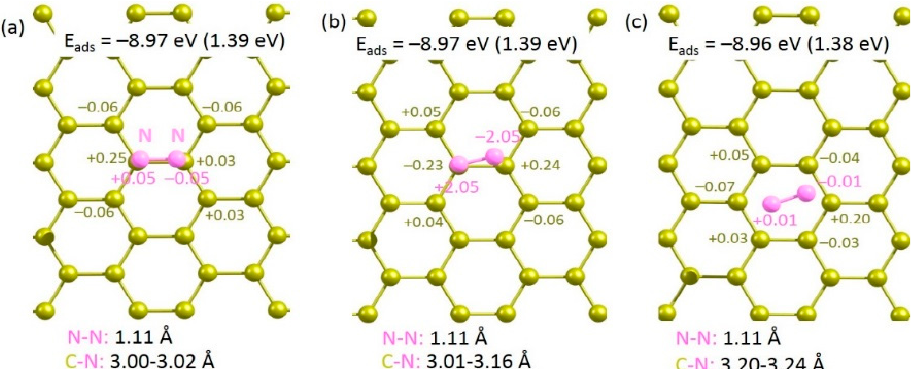
Table 2. Relative energies of three different configurations (66, C and H) of each dopant.